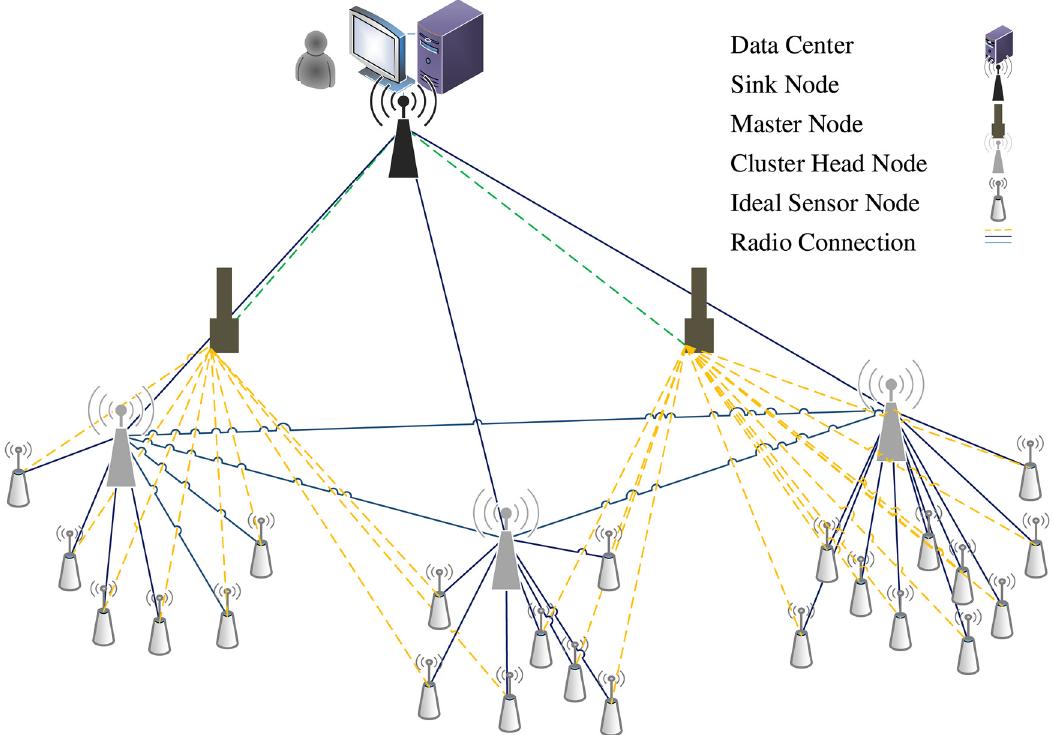
Fig 1. The adaptive architecture of